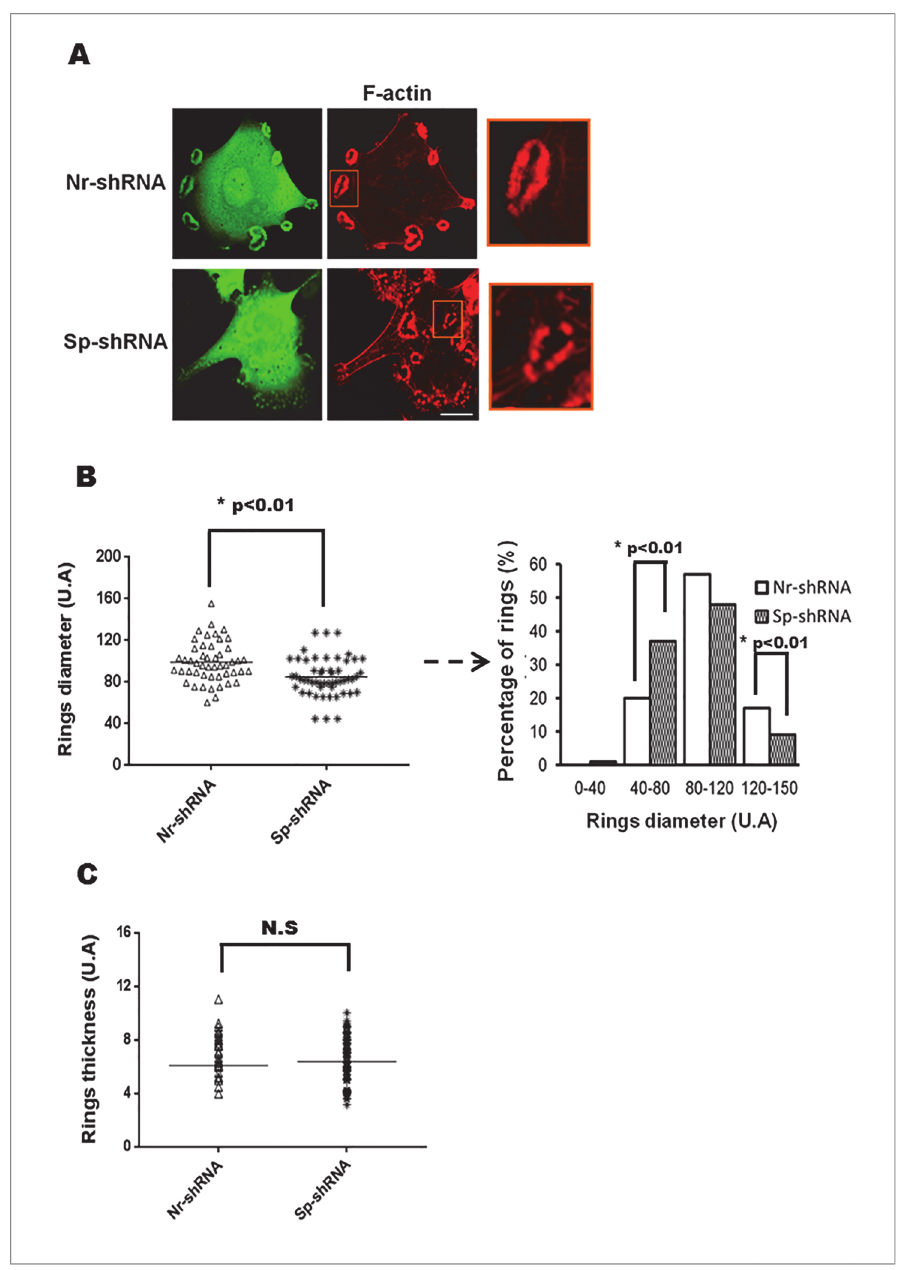
Fig 5. α II-Spectrin silencing changes invadosome morphologies. SrcY527-MEF cells were transfected for 72 hr with shRNA α II-spectrin (Sp-shRNA) or irrelevant shRNA (Nr-shRNA). (A) F-actin of transfected cells was stained with phalloidin toxin (red) allowing to visualize invadosome rings. Analysis of cells (10 fields per condition) revealed an increased number of fragmented invadosome rings in spectrin-depleted cells. (B) Invadosome ring diameters and (C) invadosome ring thickness were measured in transfected cells. Around 100 rosettes (corresponding to 20 cells, chosen in random field) were analyzed per conditions in 3 different experiments. Knockdown of α II-spectrin induces a significant decrease in ring diameters due in particular to an increase in the percentage of rings with a small size and a decrease number of large rings. In another side α II-spectrin depletion does not modify rings thickness. Scale bar: 20 μ